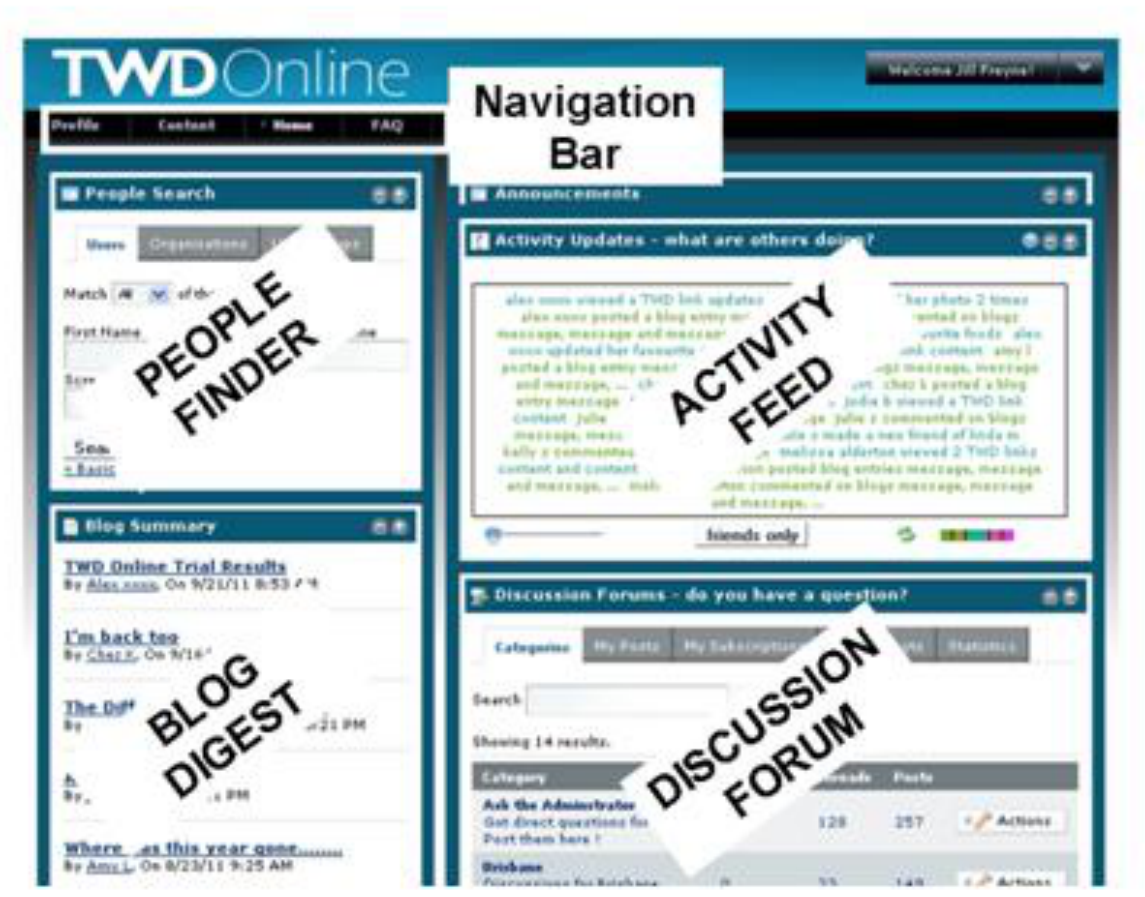
Figure 2. Example of a screenshot from the TWD Online